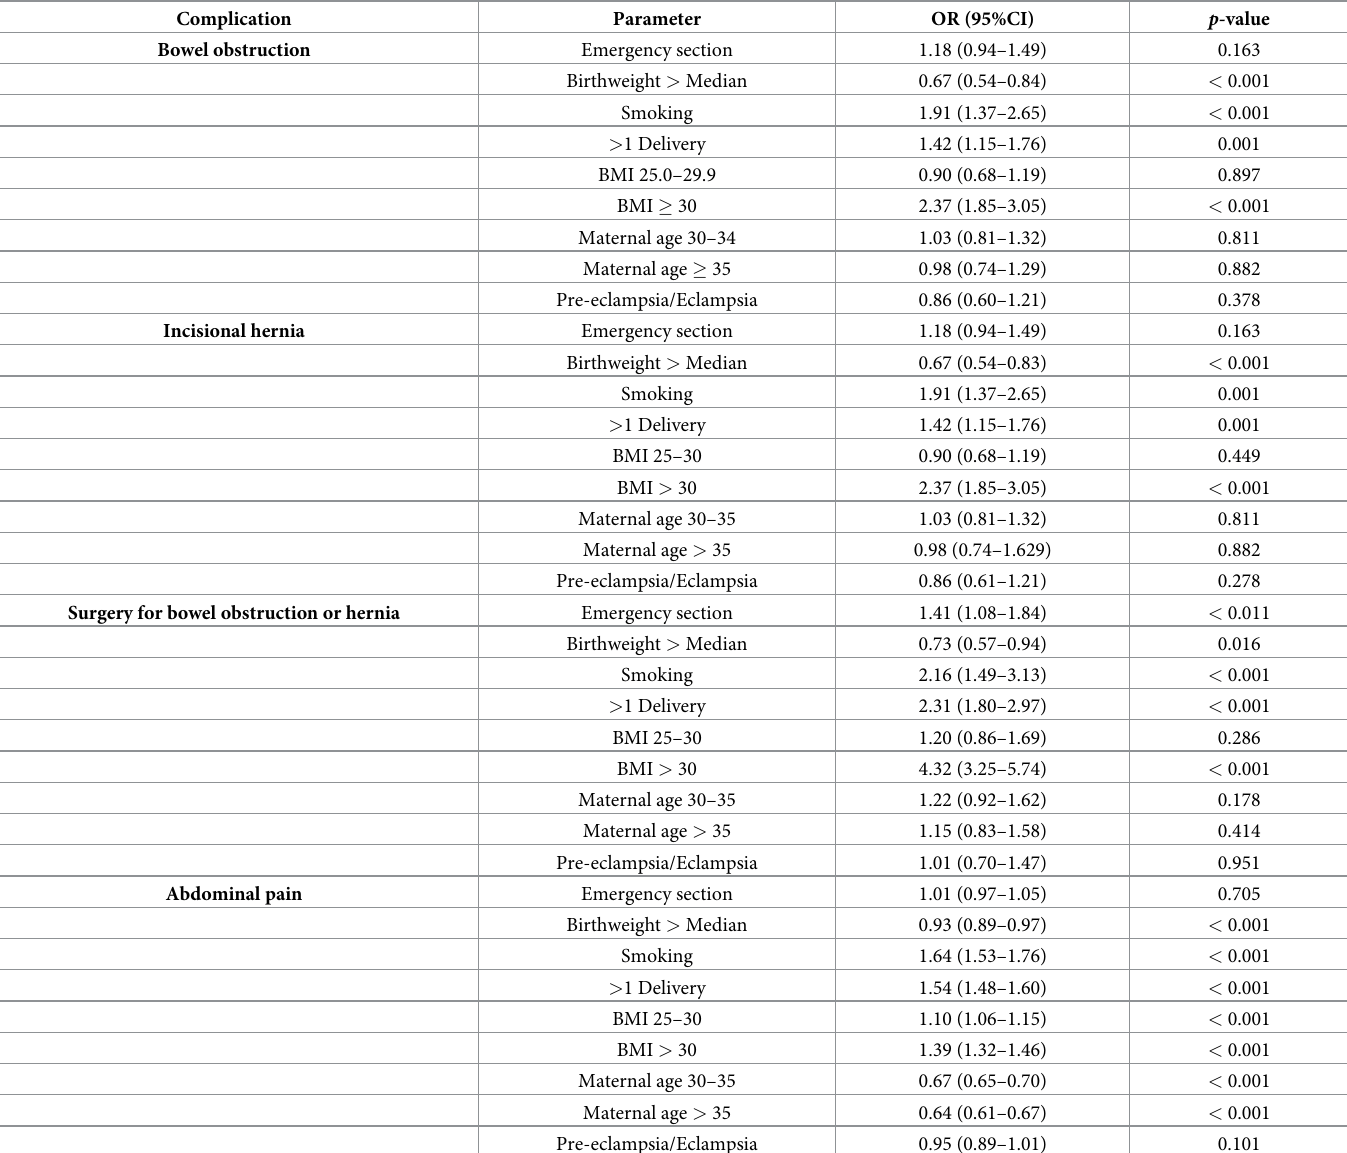
Table 4. Multivariable logistic regression analysis: Odds ratio for surgical complication after caesarean section �